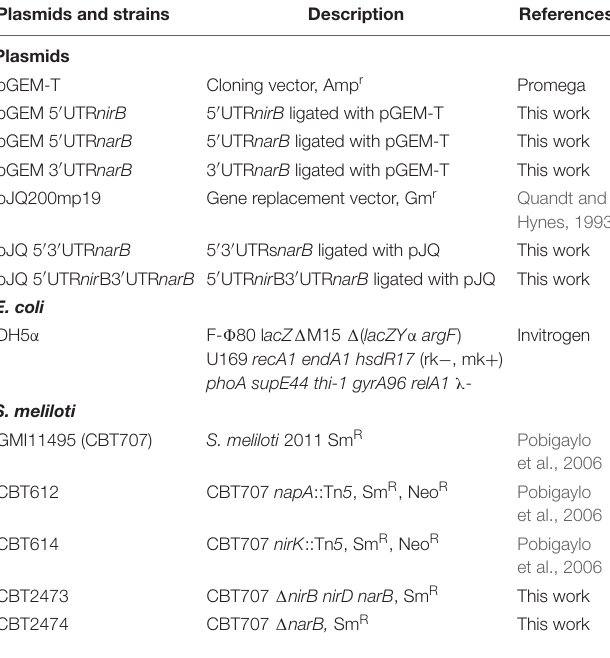
TABLE 1 | List of plasmids and strains